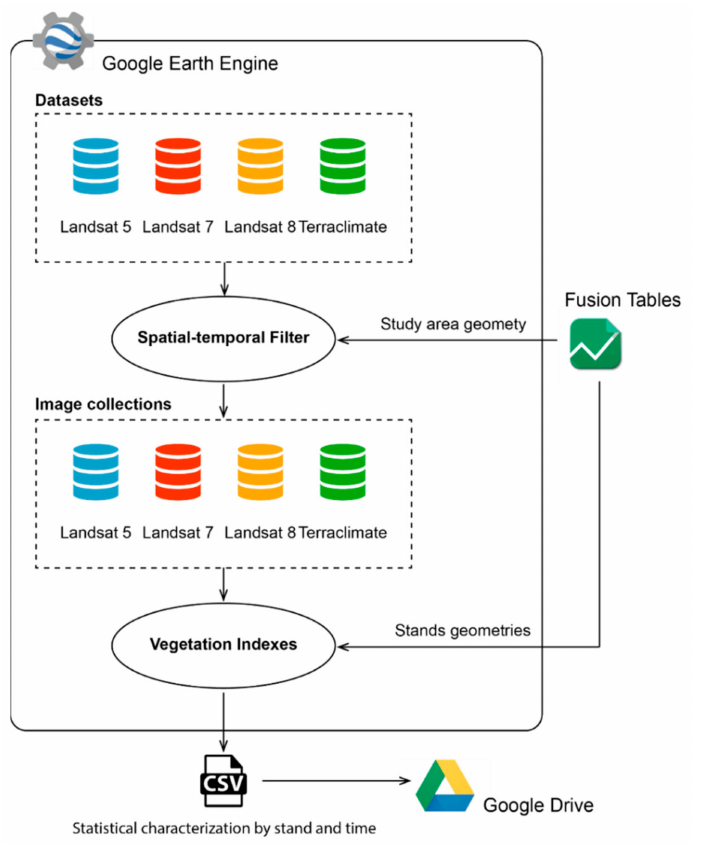
Figure 1. Flowchart describing the methodological steps of Landsat image collection processing to describe Pine Processionary Moth defoliation levels for the southeastern Andalusia Pinus forests utilizing Google Earth